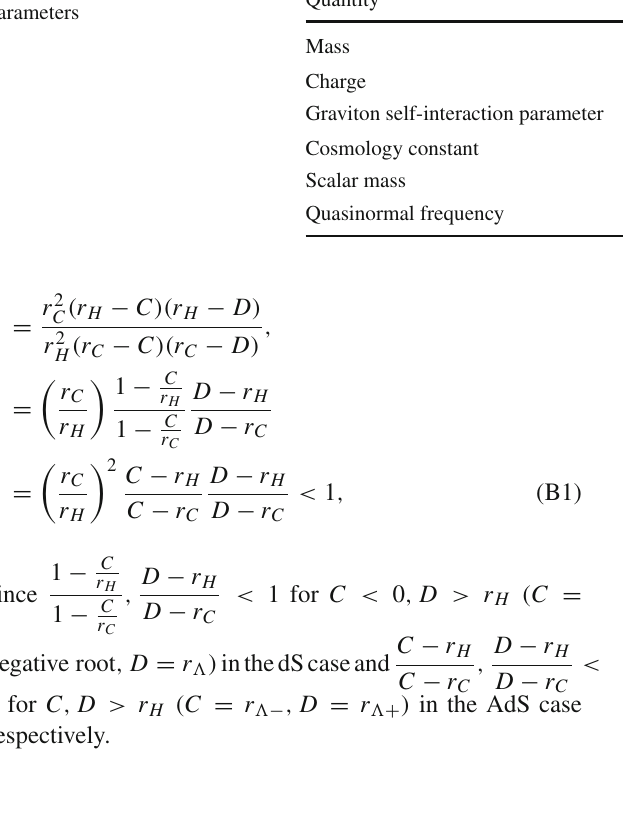
Table 5 Table of rescaled parameters